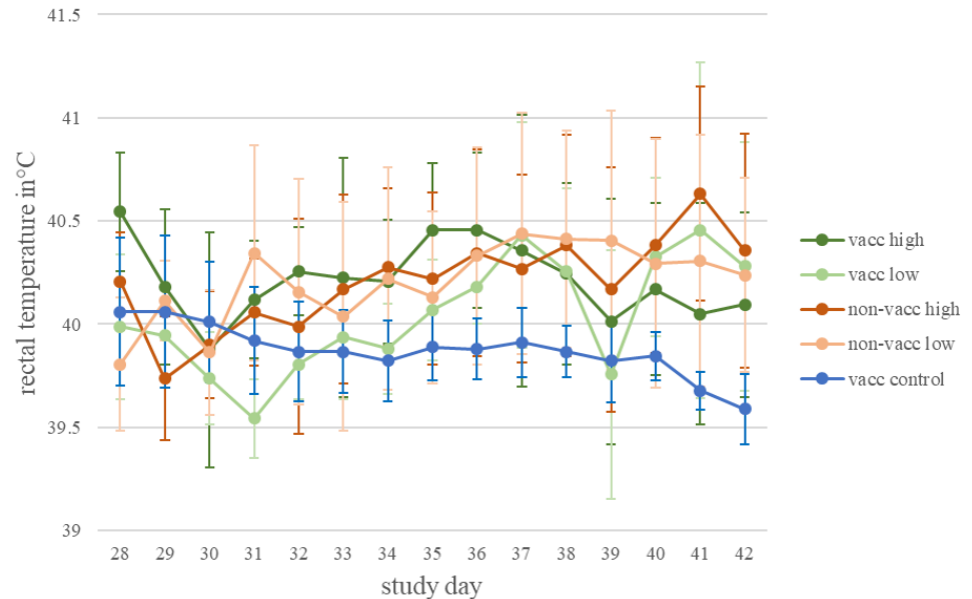
Figure 2. Rectal temperature. Mean and standard deviation of rectal temperature for each treatment group (vacc high: vaccinated, high dose [10 5 TCID 50 /dose] infected; vacc low: vaccinated, low dose [10 3 TCID 50 /dose] infected; non-vacc high: non-vaccinated, high dose infected; non-vacc low: non-vaccinated, low dose infected; vacc control: vaccinated, non-infected) after infection (study day 28 to 42).